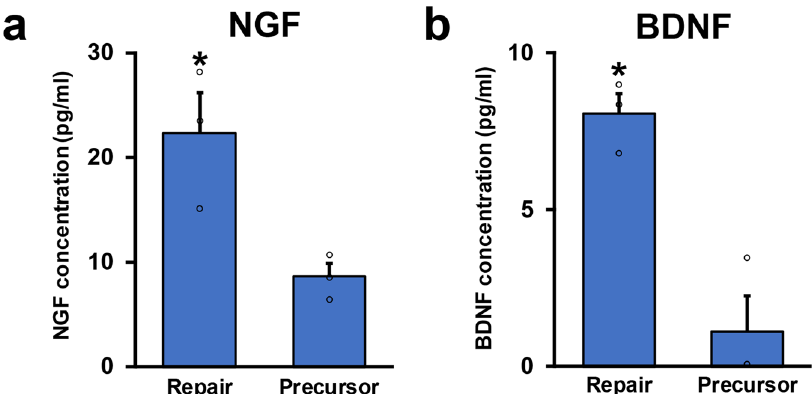
Fig. 7 Neurotrophic factor secretion of RSCs and SCPs. a NGF concentrations of conditioned medium of RSCs and SCPs. RSCs secrete more than twofold of NGF than SCPs do. Three samples per group. * P < 0.05; Student ’ s t -test. Error bars represent the SEM. b BDNF concentrations of conditioned medium of RSCs and SCPs. RSCs secrete more than fi vefold of BDNF than SCPs do. Three samples per group. * P < 0.05; Student ’ s t - test. Error bars represent the